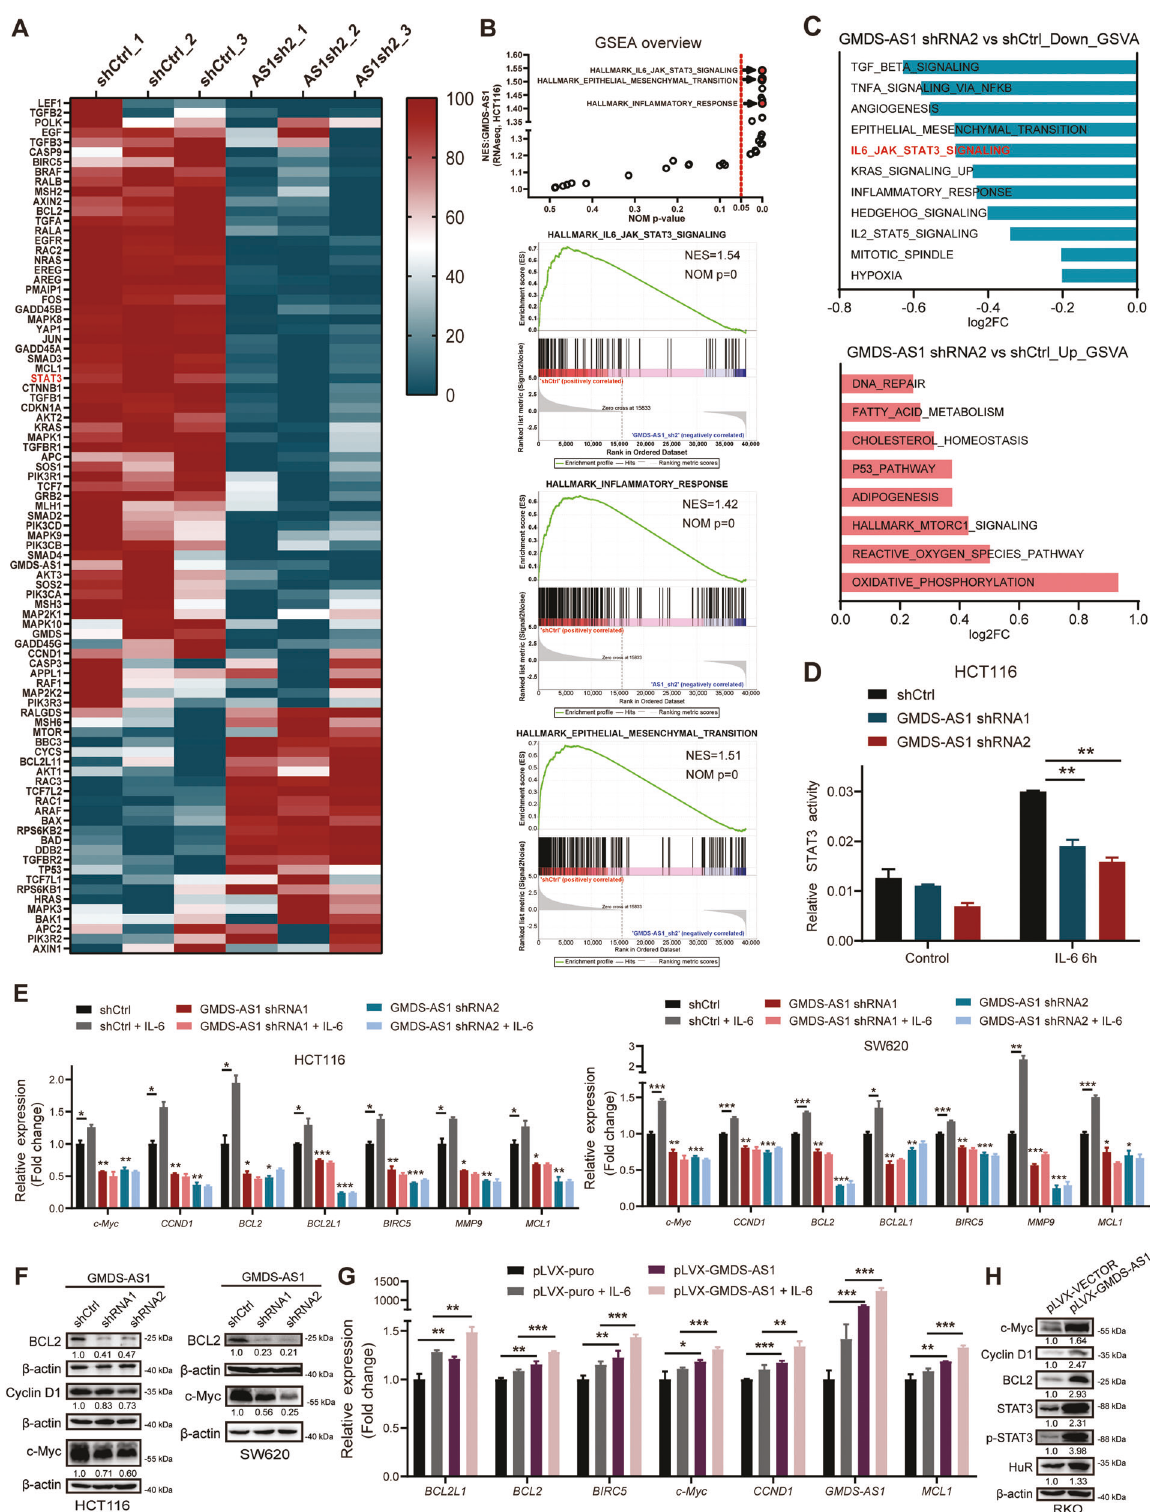
independent RNA pull-down assays (Fig. 5B). As SRSF1 depletion did not affect STAT3 expression (data not shown), we focused on the function of HuR. RIP assay con fi rmed that HuR engaged in a speci fi